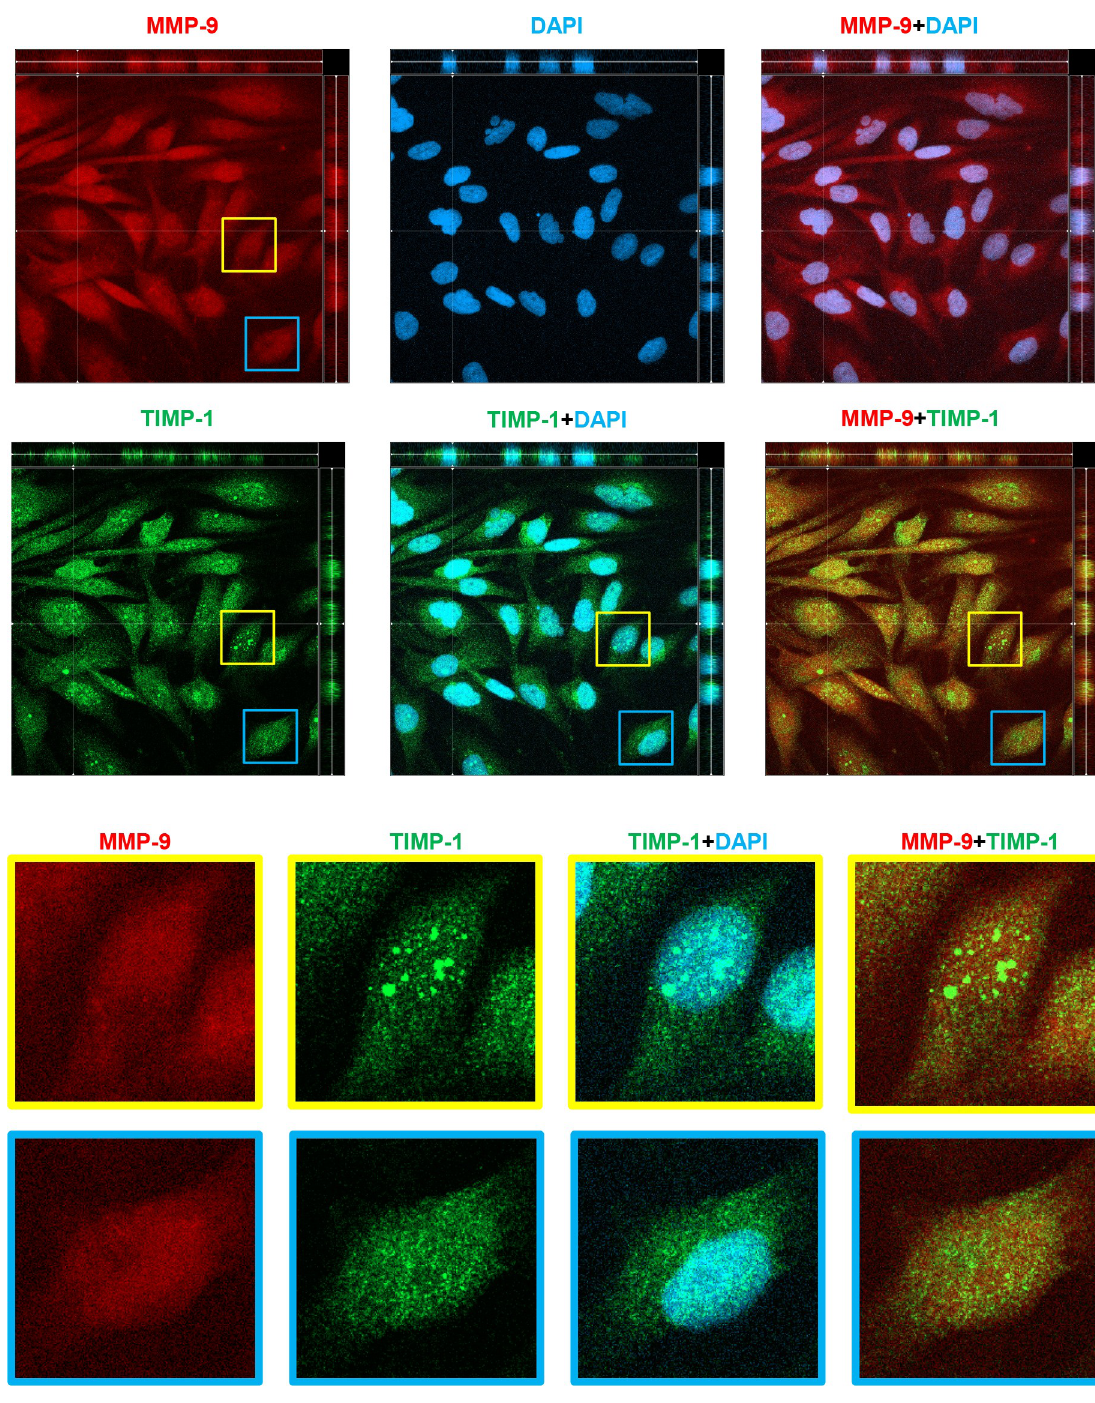
Fig 2. Intracellular compartmentalization of MMP-9 and TIMP-1 in MIO-M1 cells. MIO-M1 cells cultured in regular media were subjected to IHC fluorescent confocal microscopy with 1 μ m-interval Z-stacking. Primary antibodies specific to MMP-9 (red) and TIMP-1 (green) followed by the appropriate fluorescent secondary antibodies, as indicated in the methods, were used to dual-IHC staining of the cells. Nuclear region is defined by chromatin staining with DAPI (blue). Orthogonal projection of one focal plane is presented. Cells with two different patterns in nuclear TIMP-1 distribution are indicated by yellow and blue insets and enlarged in the bottom two rows. Scale bars, 50 μ m.